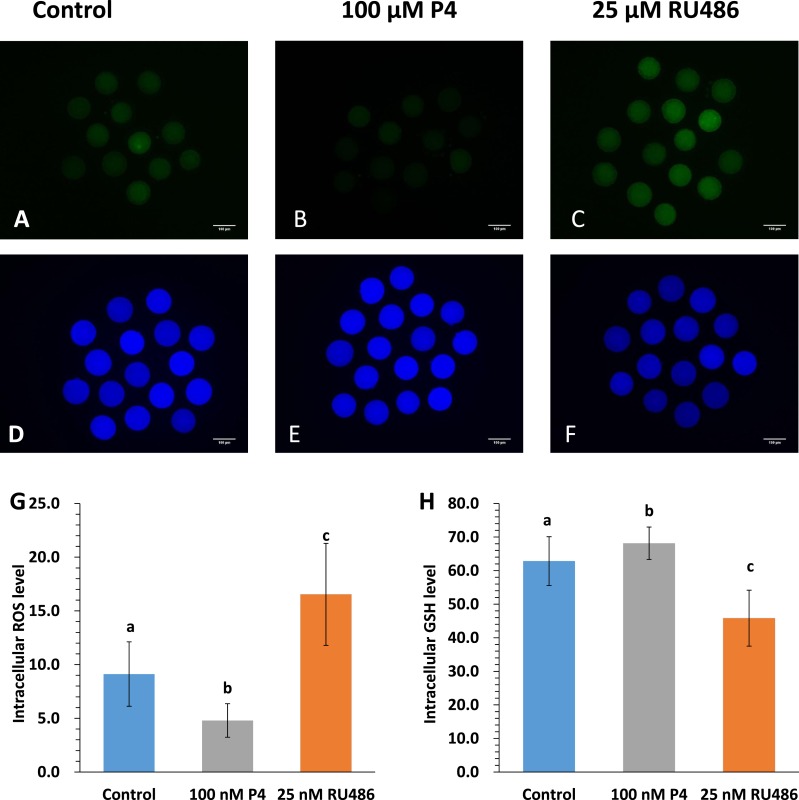
ROS and GSH images of MII oocytes.Representative images showing ROS and GSH expression in MII oocytes. Oocytes were dyed with H2DCFDA (A–C) and Cell Tracker Blue (D–F) to detect ROS levels and GSH levels. MII oocytes from the control IVM medium and 100 µM P4- or 25 µM RU486-supplemented IVM system. Effects of P4 or RU486 supplementation during IVM on intracellular ROS and GSH levels in mature oocytes (G, H). Bars with different superscripted letters (a, b, and c) in each column indicate statistically significant differences (GSH or ROS; p < 0.05). The experiment was replicated three times.